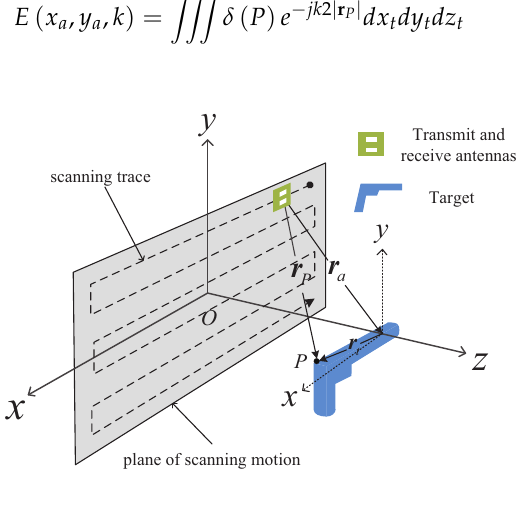
Figure 1. Imaging